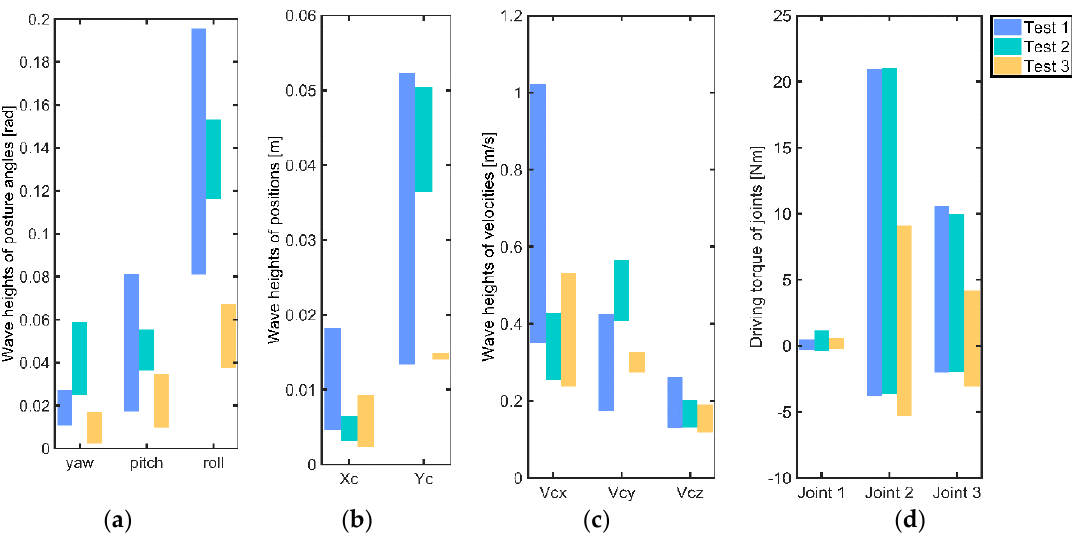
Figure 19. Variation ranges of: ( a ) wave heights of posture angles; ( b ) wave heights of positions; ( c ) wave heights of velocities; and ( d ) joint torques.